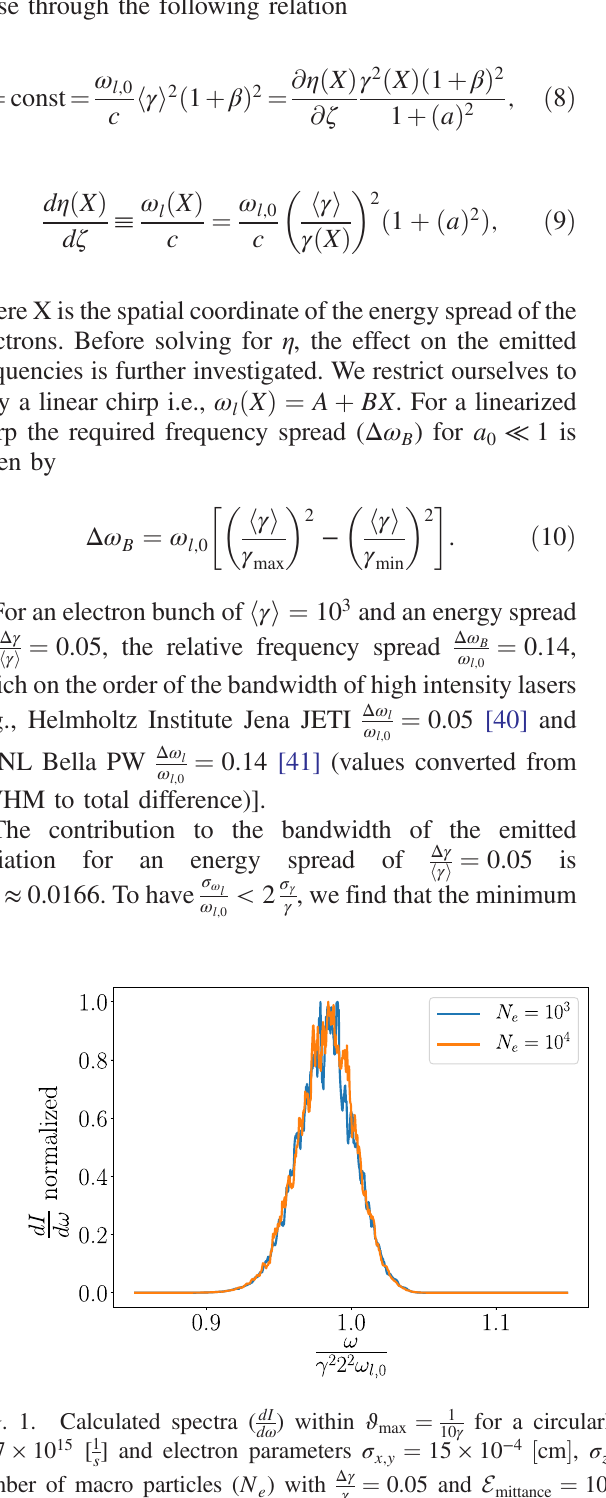
¼ 10 3 has e ¼ 0 and γ ¼ 150 c